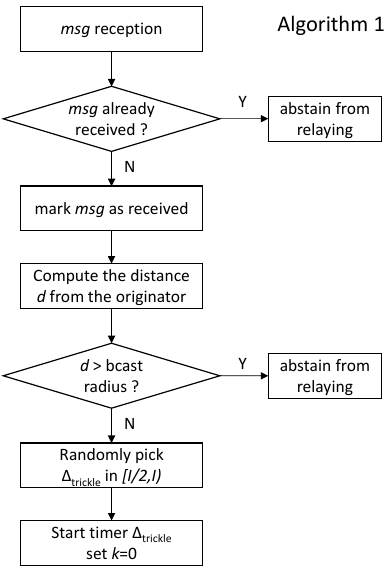
Figure 4. Flowchart of UE-side operations at message (msg) reception.